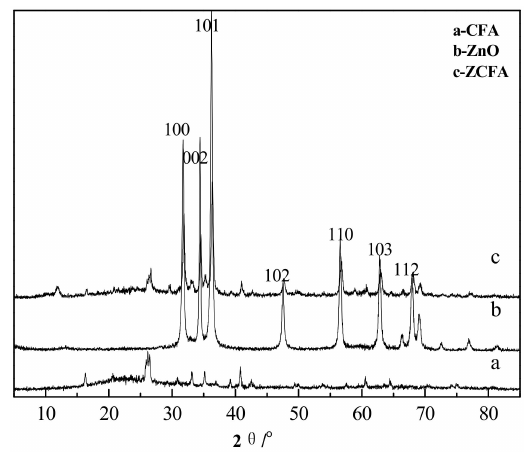
Figure 13. XRD spectrum of CFA, ZnO, and ZCFA